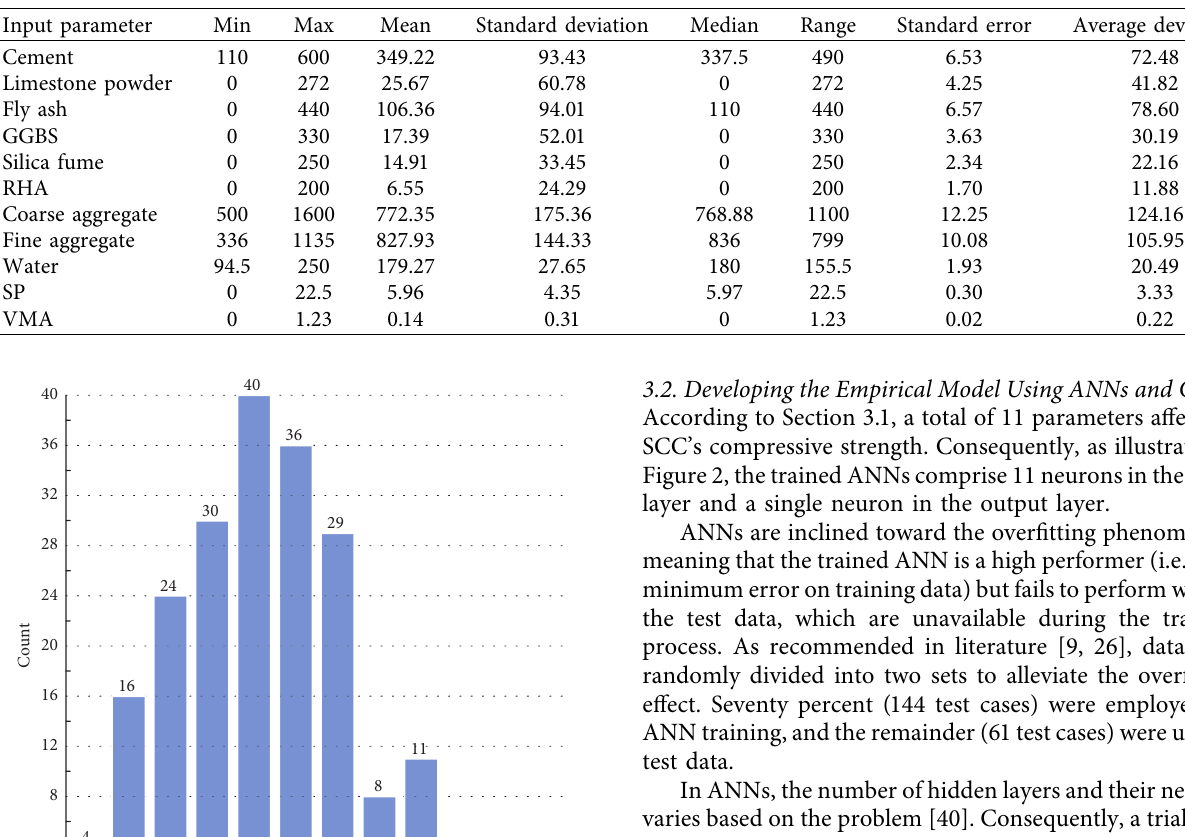
Table 1: Descriptive statistics of the experimental data.